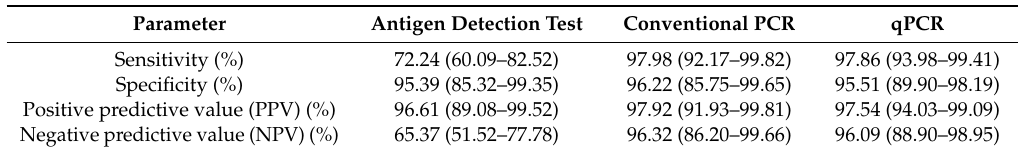
Table 4. Test sensitivity (Se), specificity (Sp), positive predictive value (PPV), and negative predictive value (NPV) with their 95% credible intervals for antigen detection test, conventional PCR and qPCR (at optimised cut-o ff Ct value of 23.10) as obtained from Bayesian latent class analysis with informative priors.